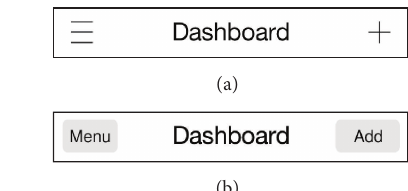
Figure 5: (a) The buttons of the original app on first launch; (b) the changed